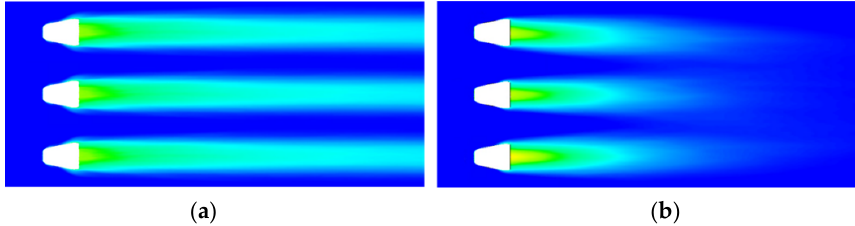
Figure 9. Comparison of film cooling effectiveness distributions ( a ) without and ( b ) with upstream turbulence in the boundary layer when the blowing ratio is 2.0.